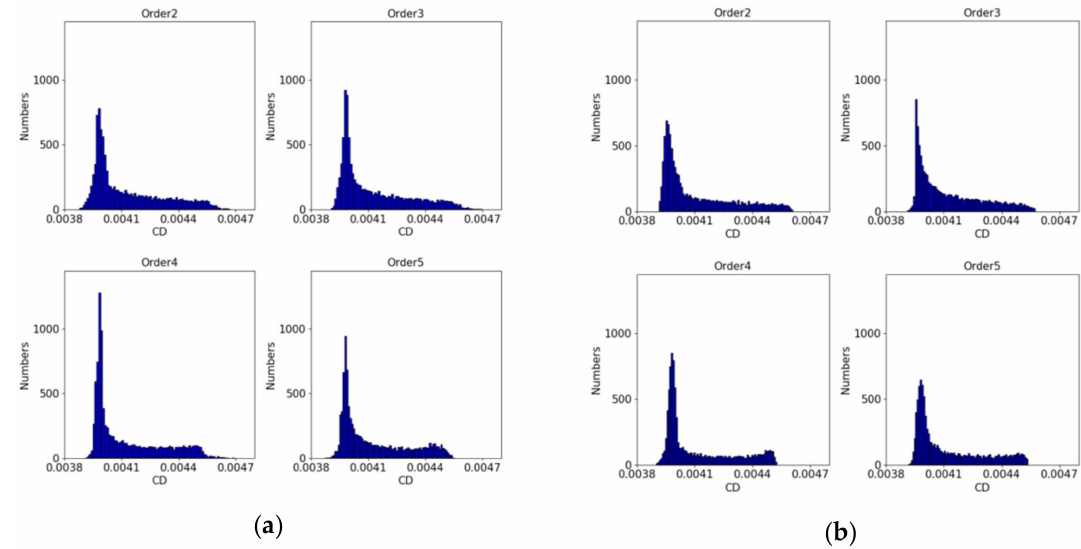
Figure 4. PDF analysis of the drag coefficient: ( a ) point-collocation non-intrusive polynomial chaos; and ( b ) non-intrusive spectral projection.